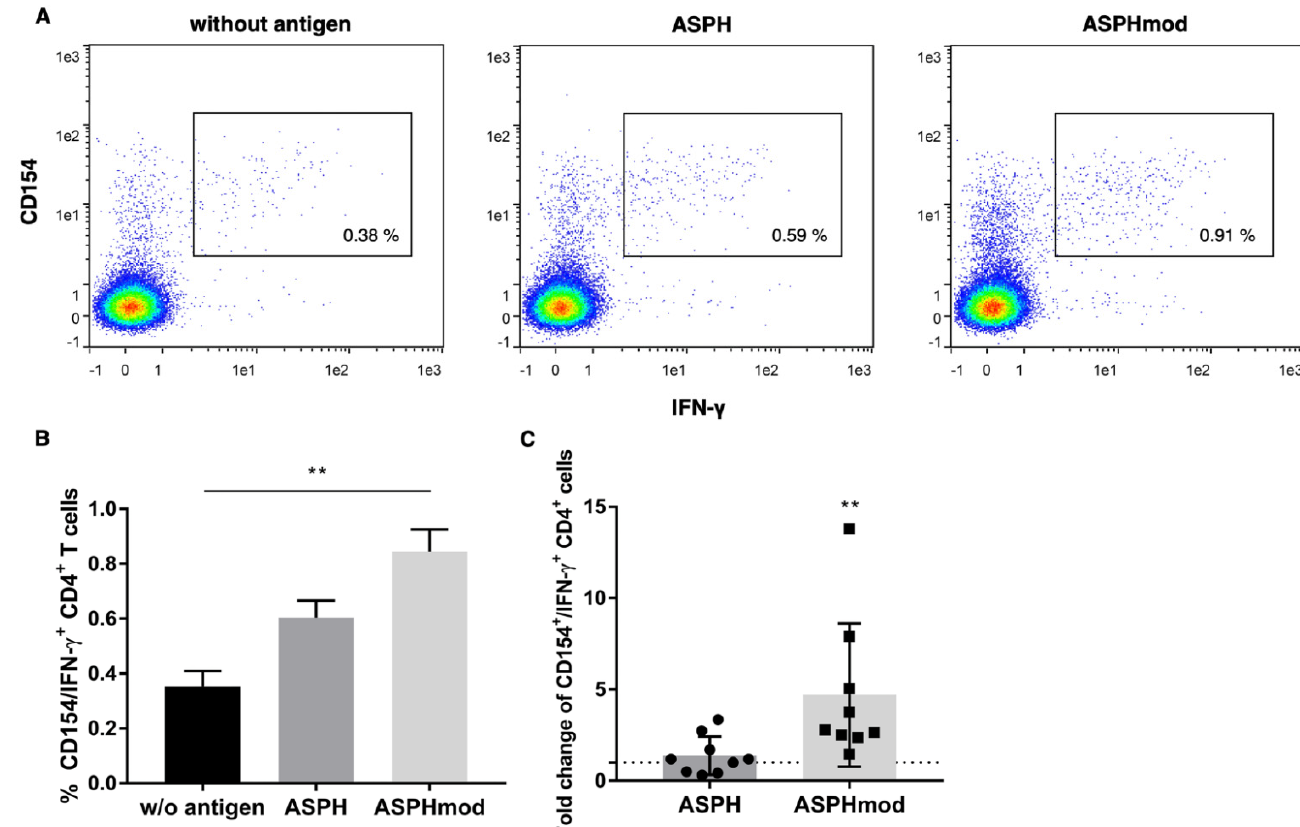
Figure 3. ASPHmod-pulsed moDCs induce an increase in CD4 + CD154 + IFN- γ + T cells. ( A ) Repre- sentative flow cytometric analysis of the T cell response of a single individual. ( B ) Data represent the means ± SD of the same individual assessed in quintuplicate: ** significantly different, p < 0.01 (Kruskal–Wallis test). ( C ) Fold change in CD4 + CD154 + IFN- γ + T cells relative to cells restimulated with the non-pulsed moDC control. Data represent the means ± SD of nine individuals: ** signifi- cantly greater, p < 0.01 (Mann–Whitney test).